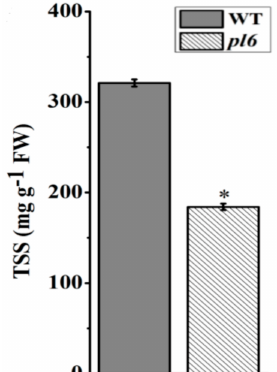
Figure 9. Detection of total soluble sugar (TSS) contents between the WT and the pl6 mutant at the late tillering stage. All values are the mean ± SD of three biological replications. * p < 0.05 by Tukey’s